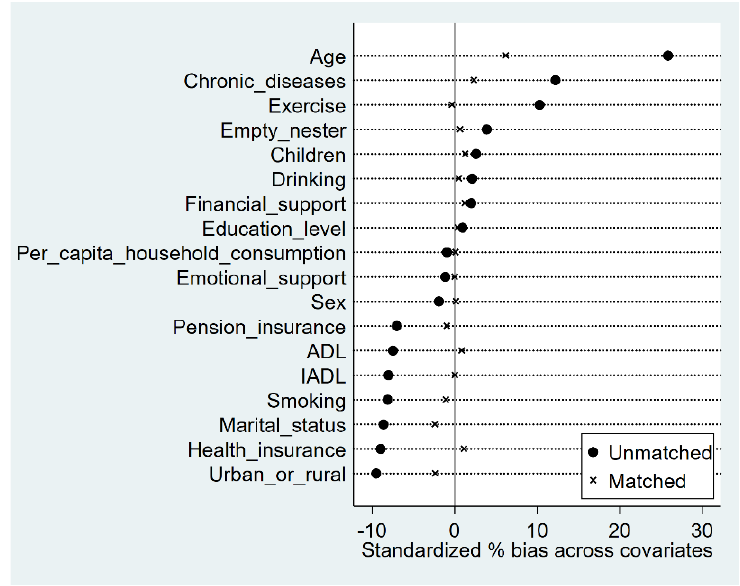
Figure 1. Standardized % bias across covariates standardized differences (%) (nuclear matching).